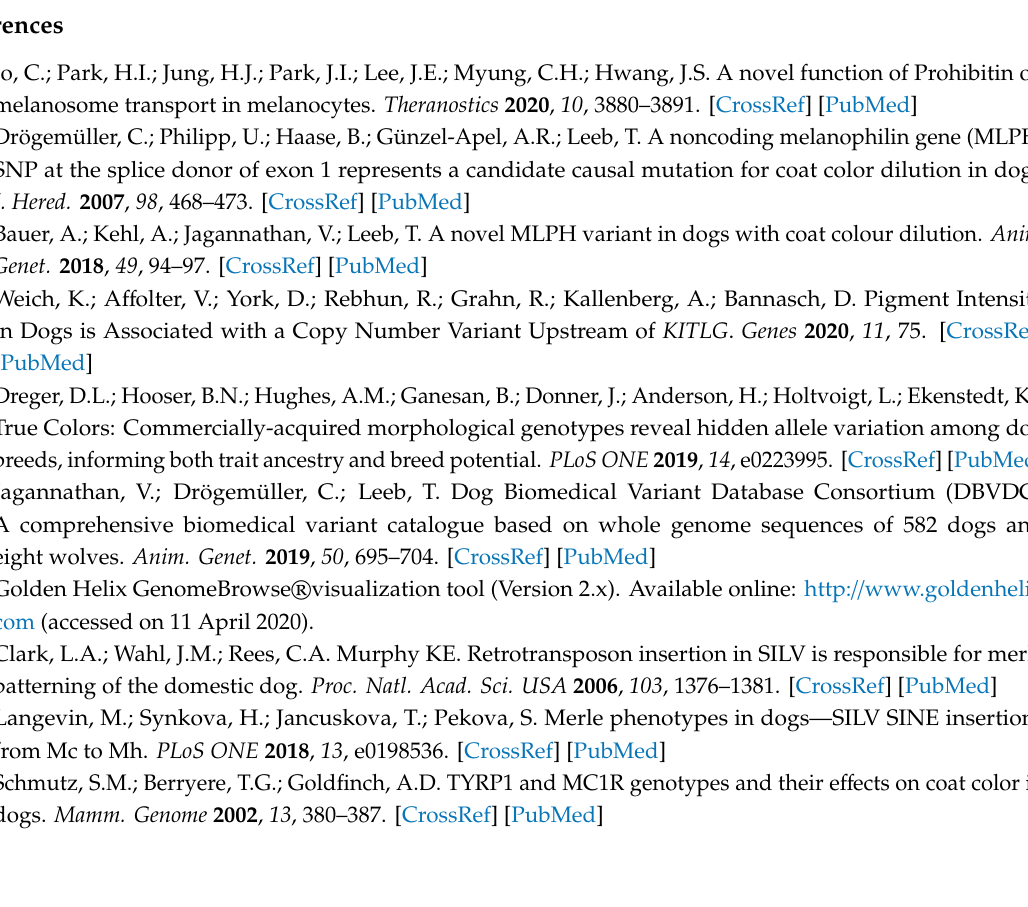
Table S1: Primers used for the PCR amplification and sequencing of MLPH exons, Table S2: Genotypes of all dogs in this